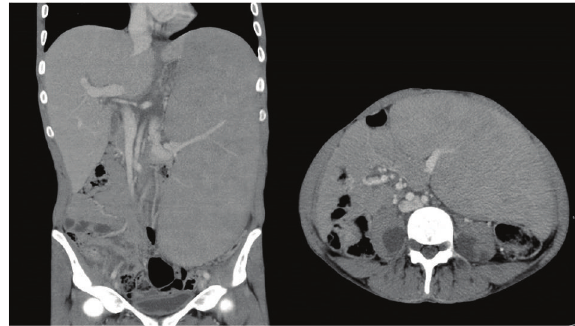
Figure 1: Peripheral blood film showing left shift and monocytes.